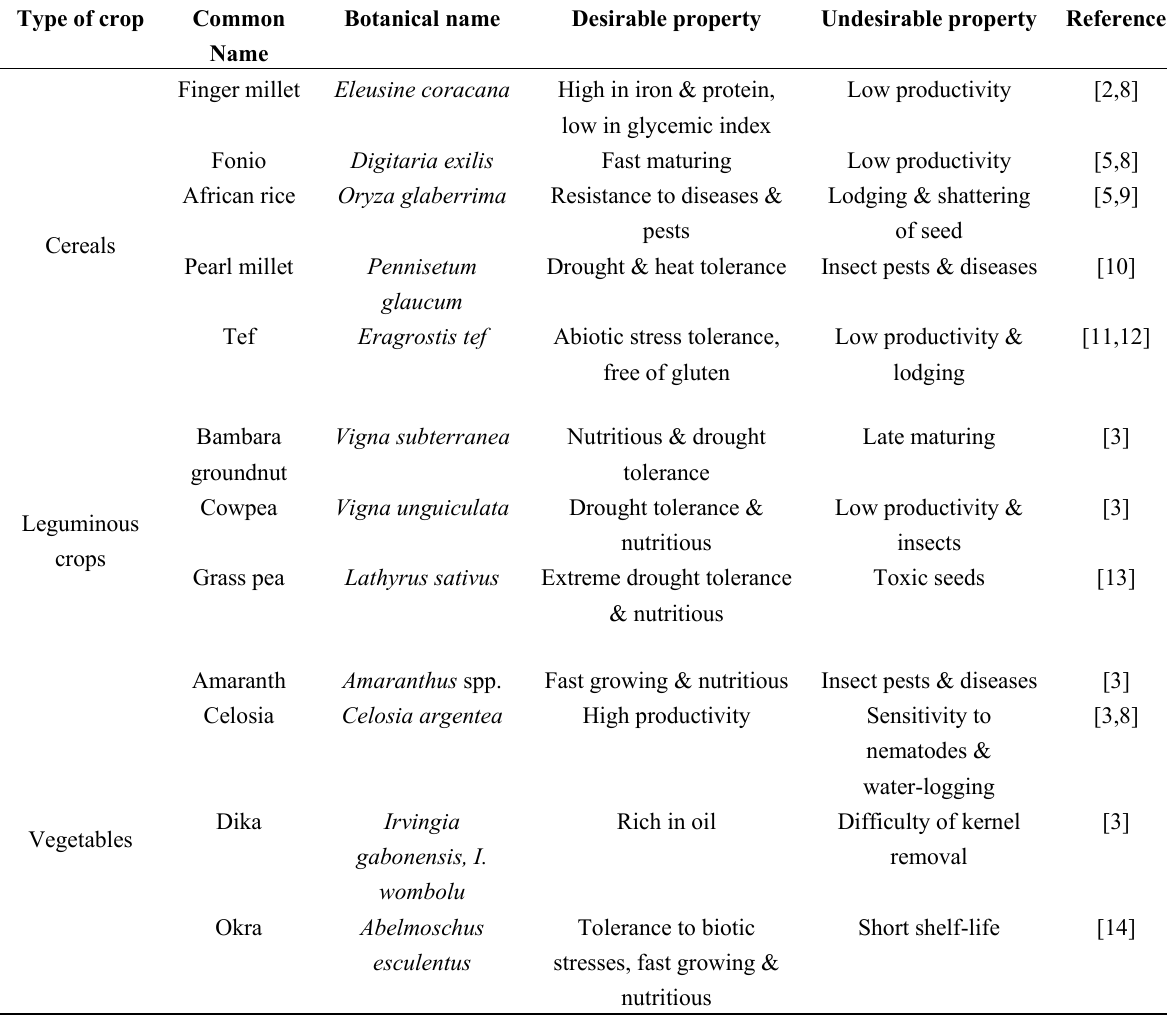
Table 1. Major understudied crops of Africa and their desirable and undesirable